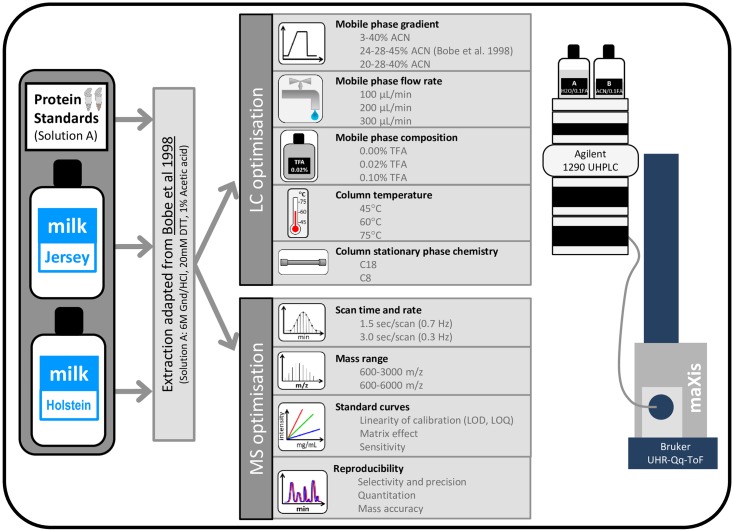
Experimental design.